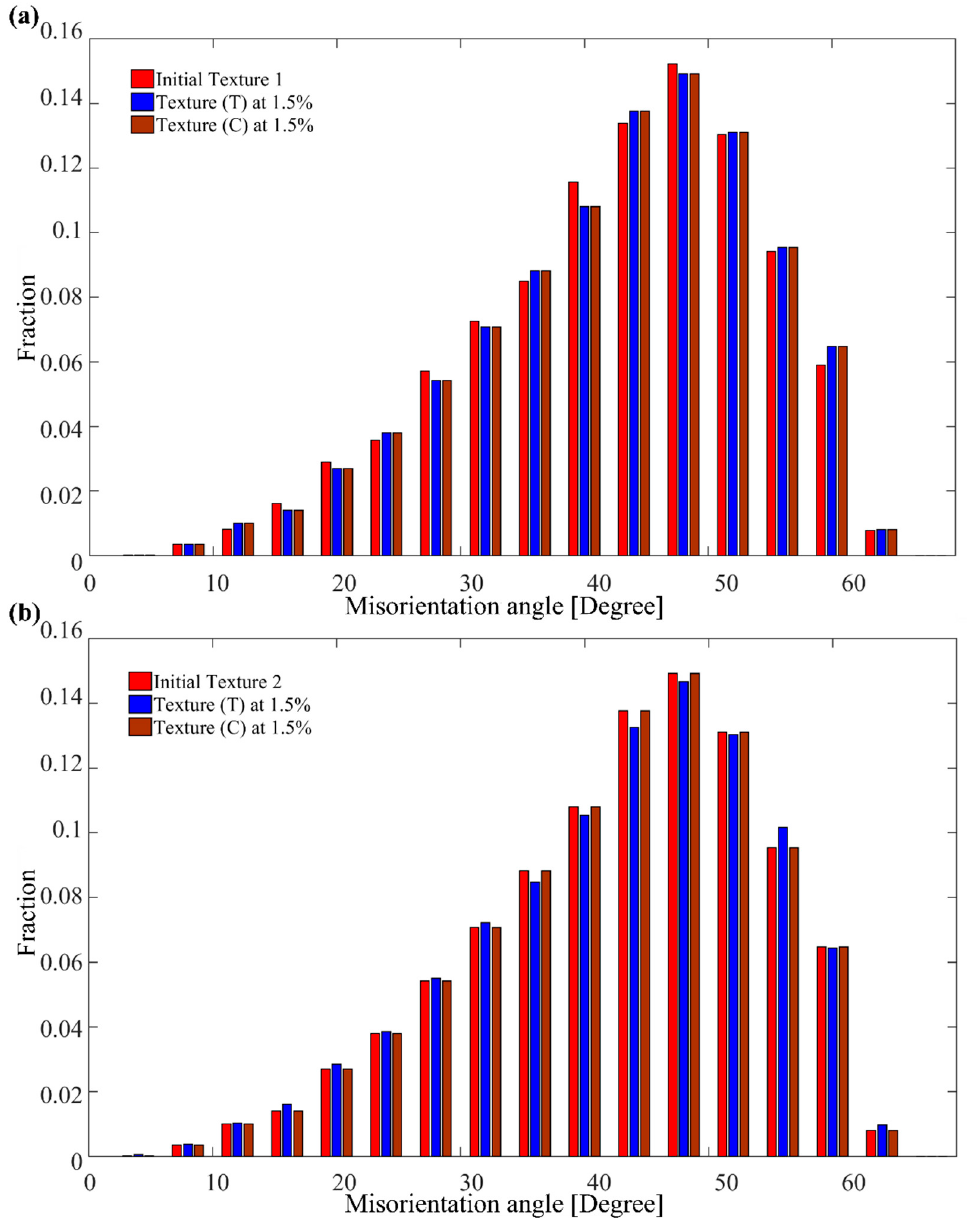
Figure 6. Comparison of misorientation angle distribution for specimens with gradient structures in tension and compression for two textures, ( a ) texture 1 and ( b ) texture 2. The corresponding initial texture is also shown. Results are shown for IF steel specimens at 15% strain.